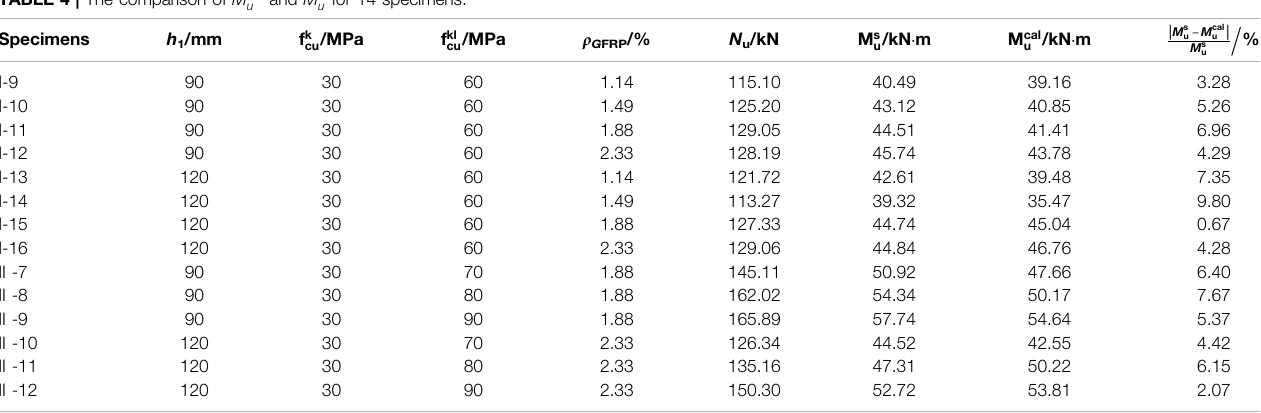
TABLE 4 | The comparison of M cal u and M s u for 14 specimens.